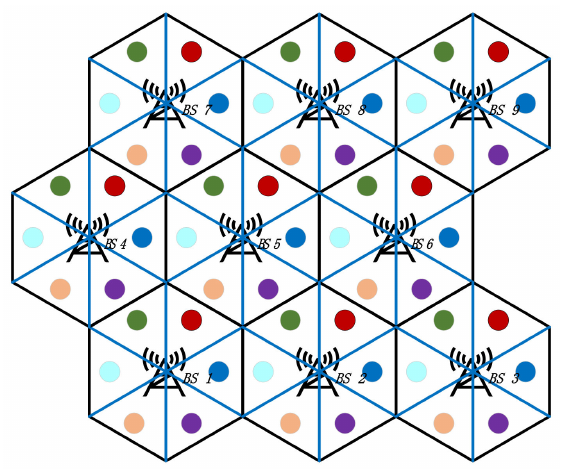
Figure 6. Diagram of a 3 × 3 distributed 5G macro BS network.